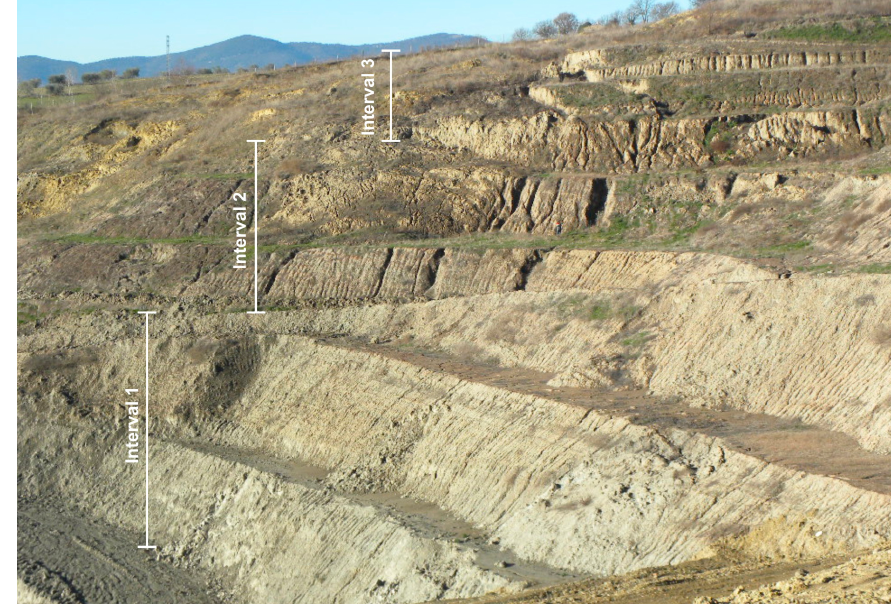
Figure 2. Overview of the Cava Nuova section and the limits of Intervals